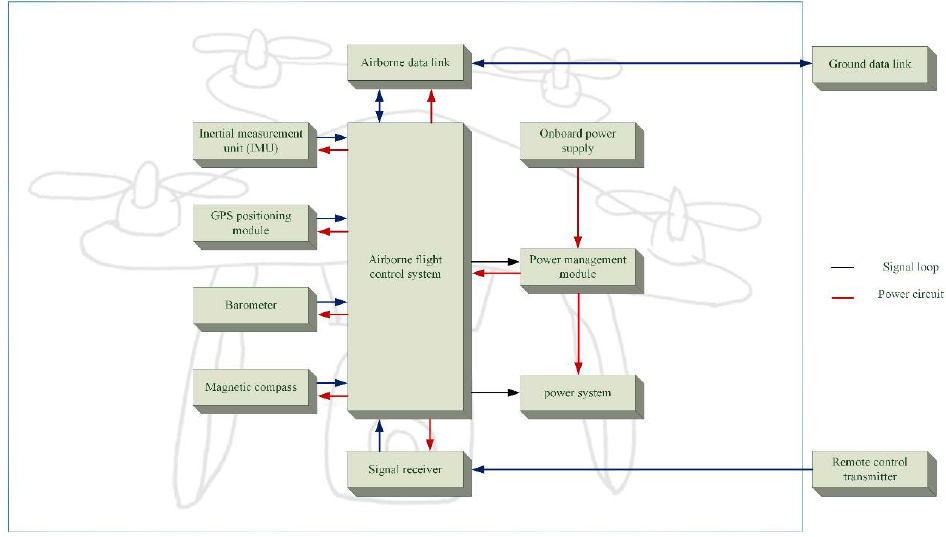
Figure 4. UAV power circuit and signal circuit